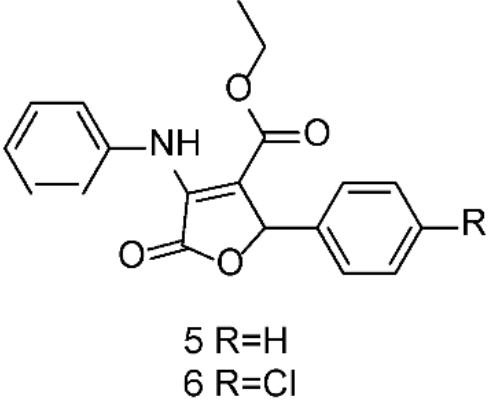
Figure 6. Structures of 5 and 6 furanones.